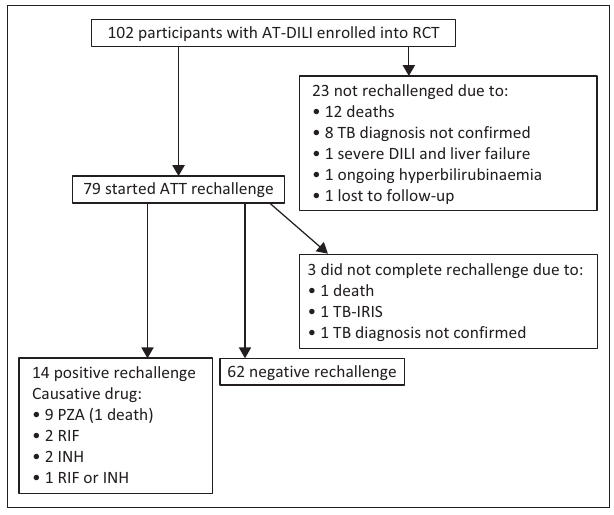
102 participants with AT-DILI enrolled into